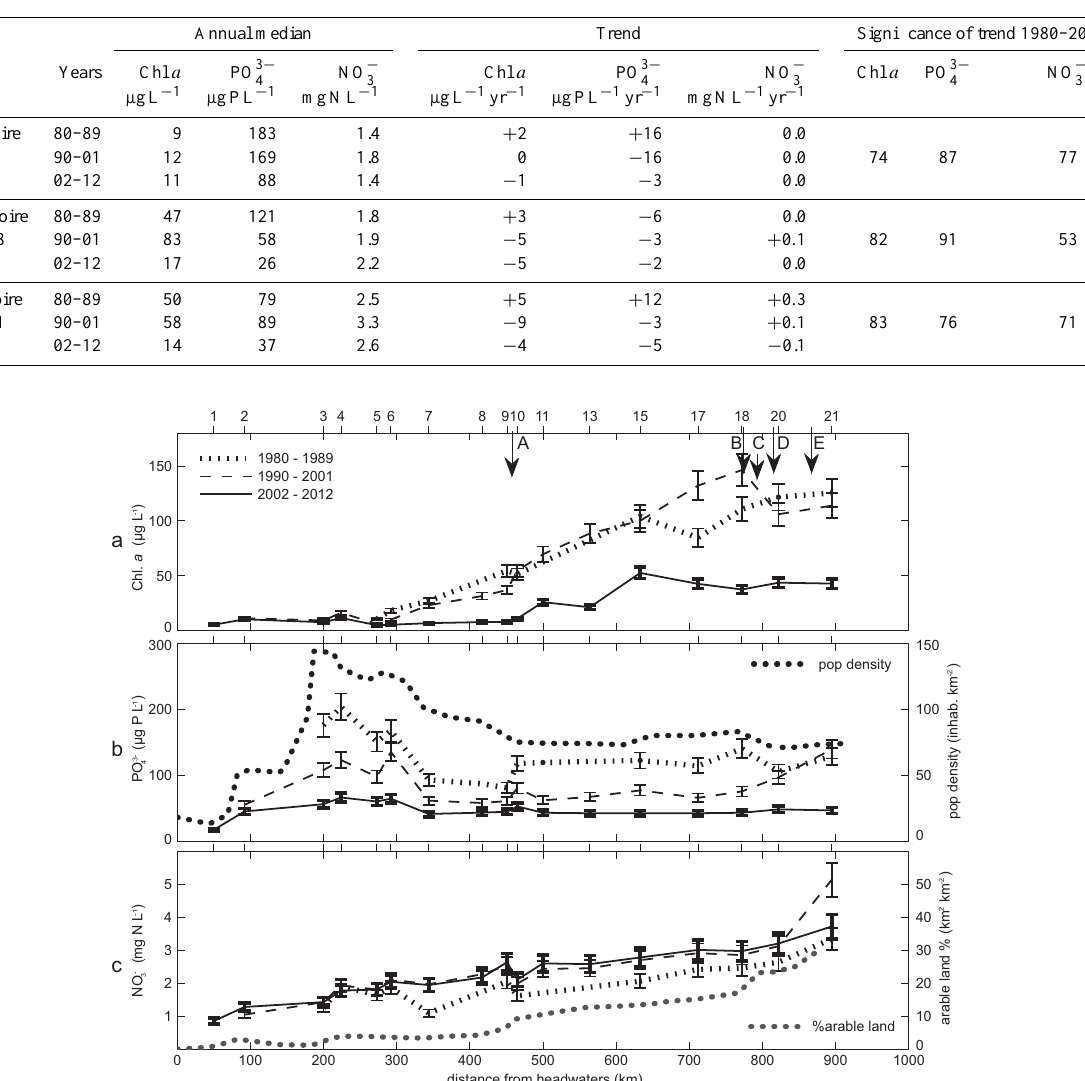
(b) and NO − (c) . Averages for three periods, in relation 4 3